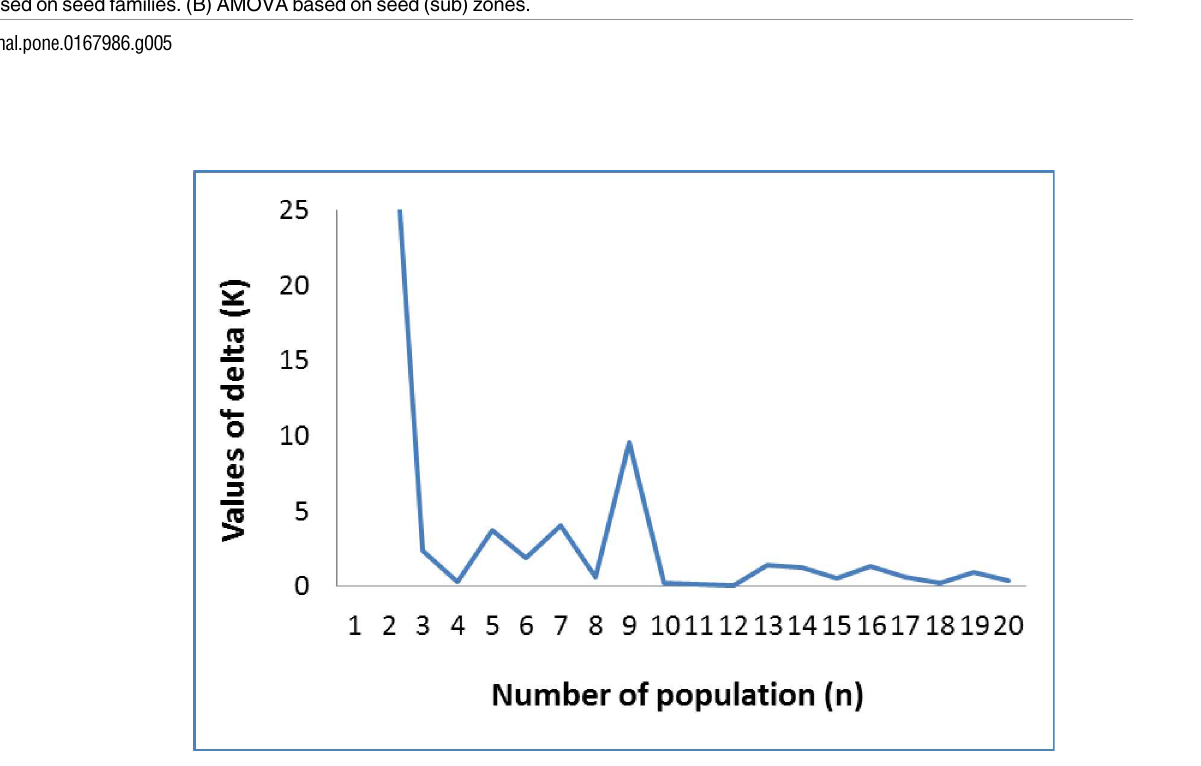
Fig 6. Bayesianclustering analysis for estimation of population structure using program STRUCTURE. Δ K plots by Evanno’s method. Graph of delta K values (y-axe) againstassumed sub- populations (x-axe) showingthe ideal numberof groups present in a set of whitebarkpine seed families collectedfor a breedingprogram. Genotypic data were collectedfor 71 ns-SNP loci across all genotyped individuals. The highestpeak shows the best K =